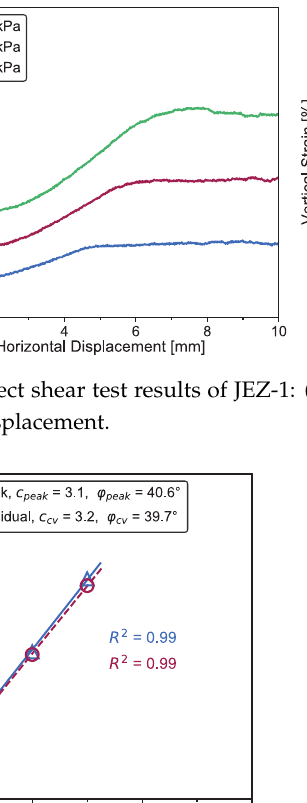
Figure 6. Direct shear test results of JEZ-1: ( a ) shear stress and ( b ) vertical strain as a function of horizontal displacement.